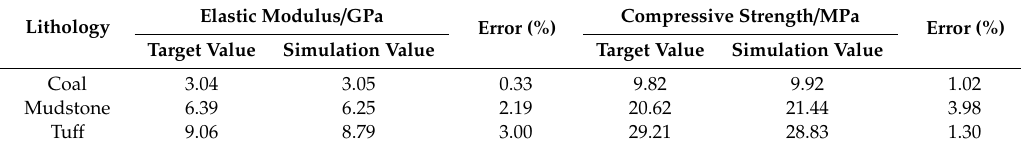
Table 4. Calibrated Young’s modulus and the compressive strength value in the UDEC model.